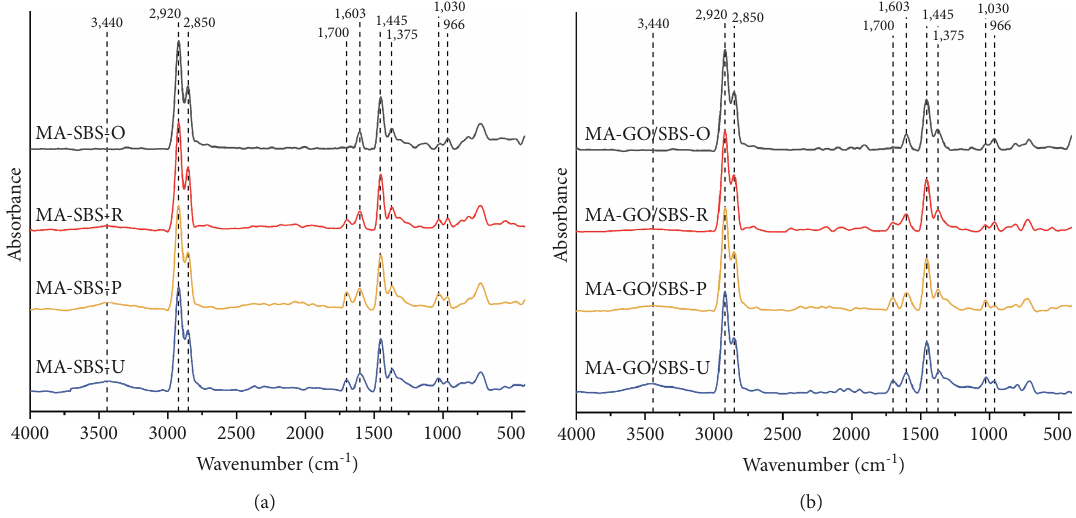
Figure 6: FTIR spectra recorded for MA-SBS (a) and MA-GO/SBS (b) before and after